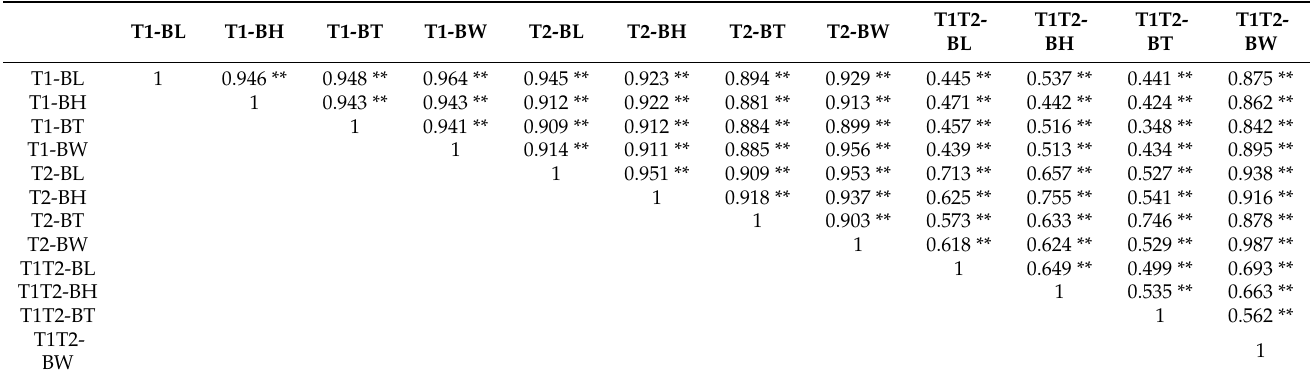
Table 2. Pearson correlations between the traits in Yellow River carp at the T1, T2 and T1T2 stages.